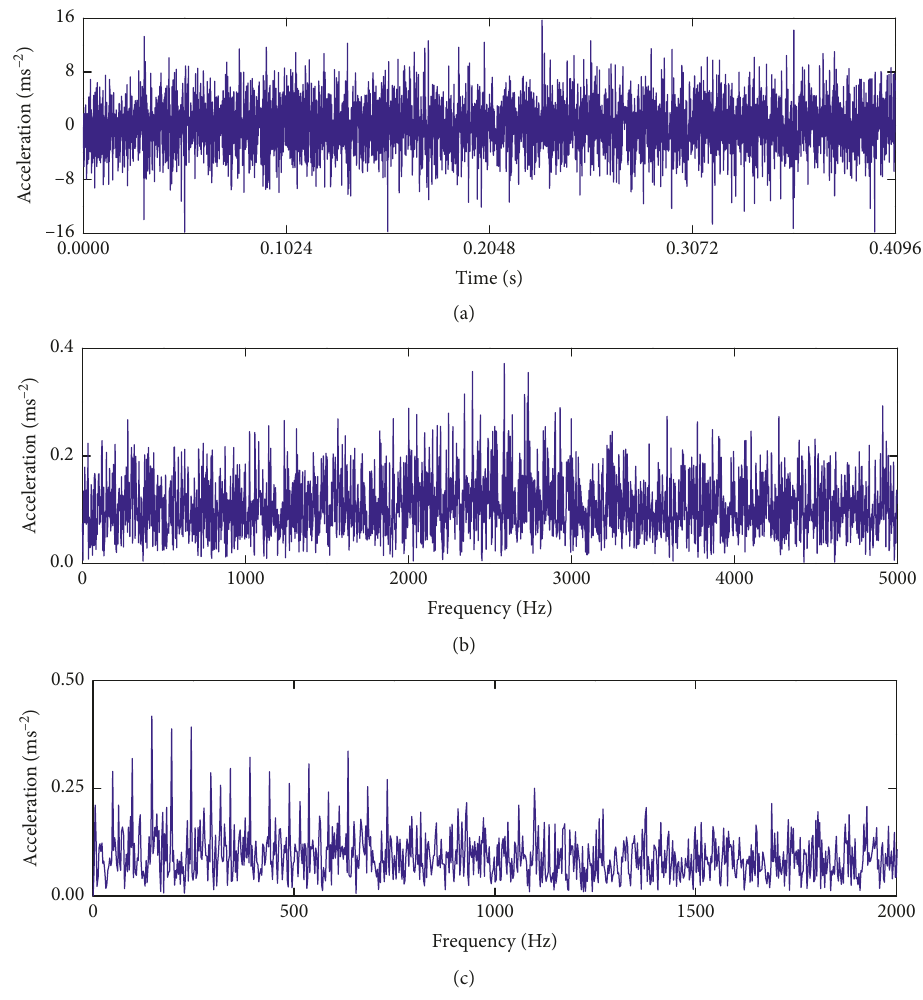
Figure 11: Simulated IRS: (a) original signals; (b) its Fourier spectra; (c) its envelope spectrum.